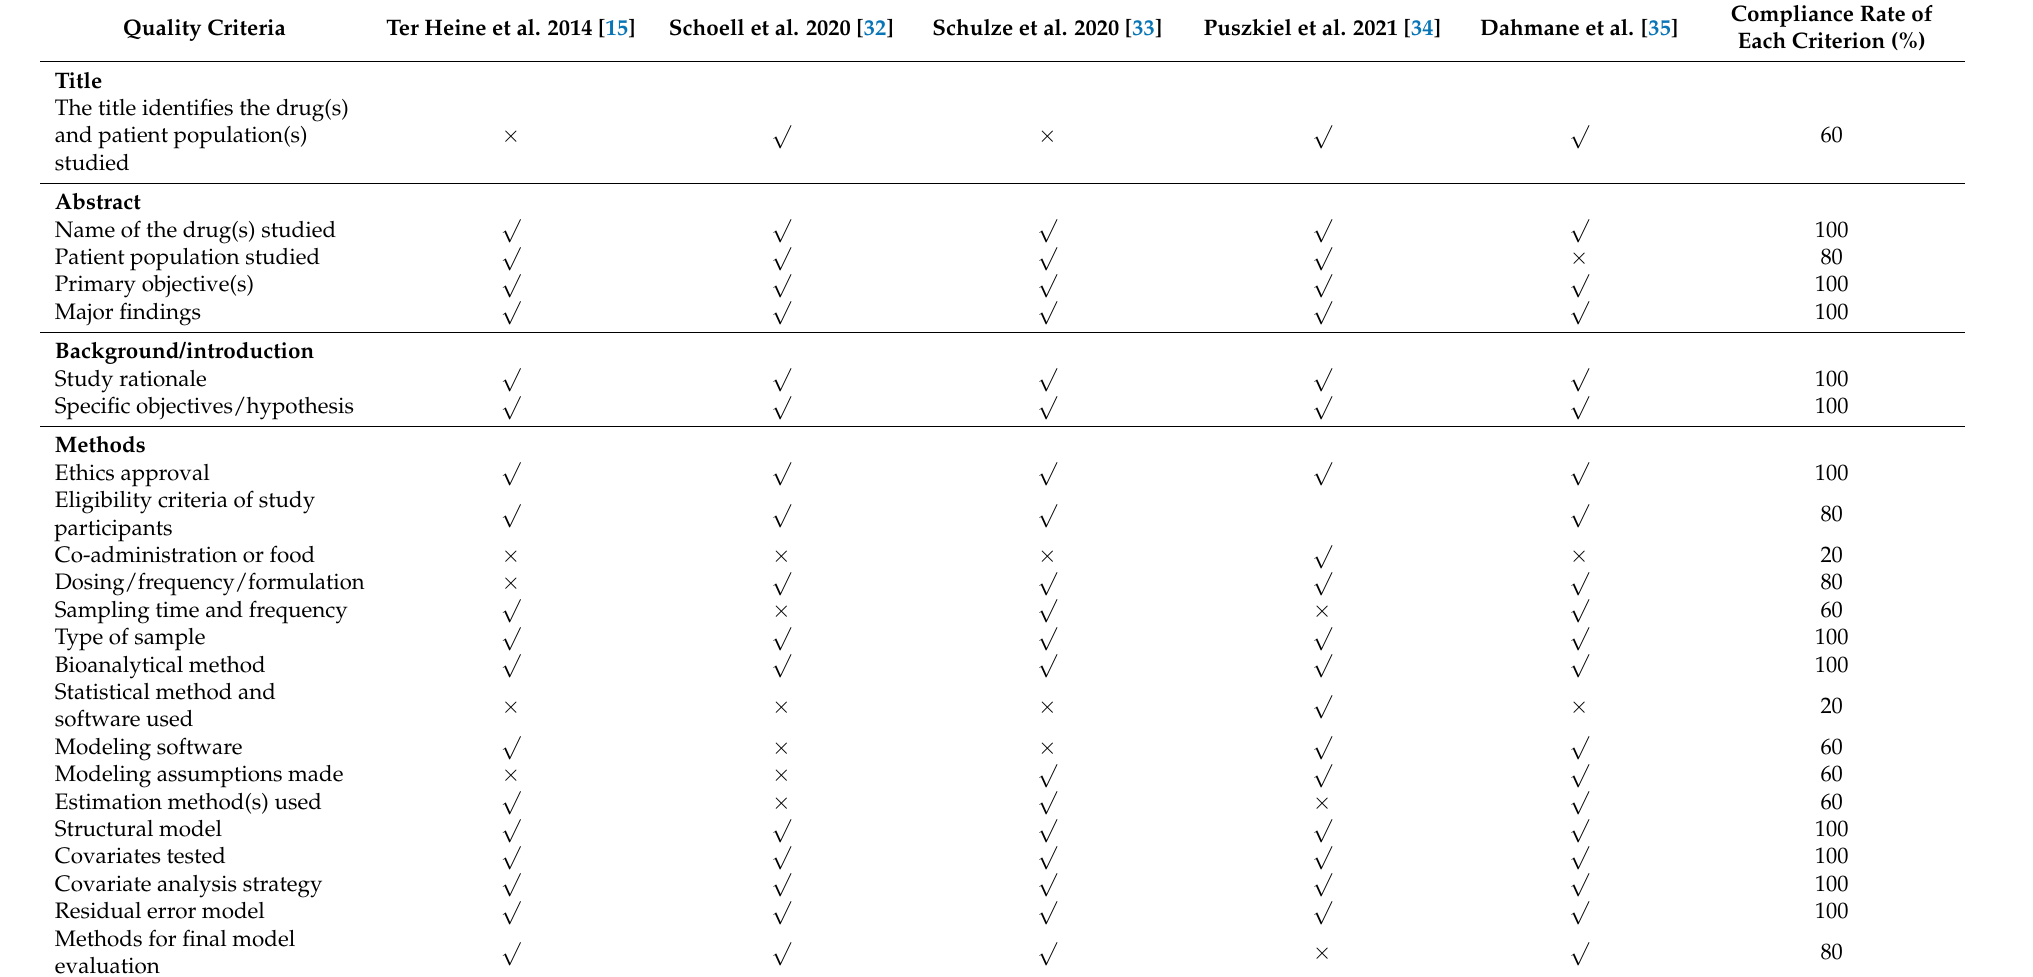
Table 1. Checklist for assessing the quality of tamoxifen PopPK